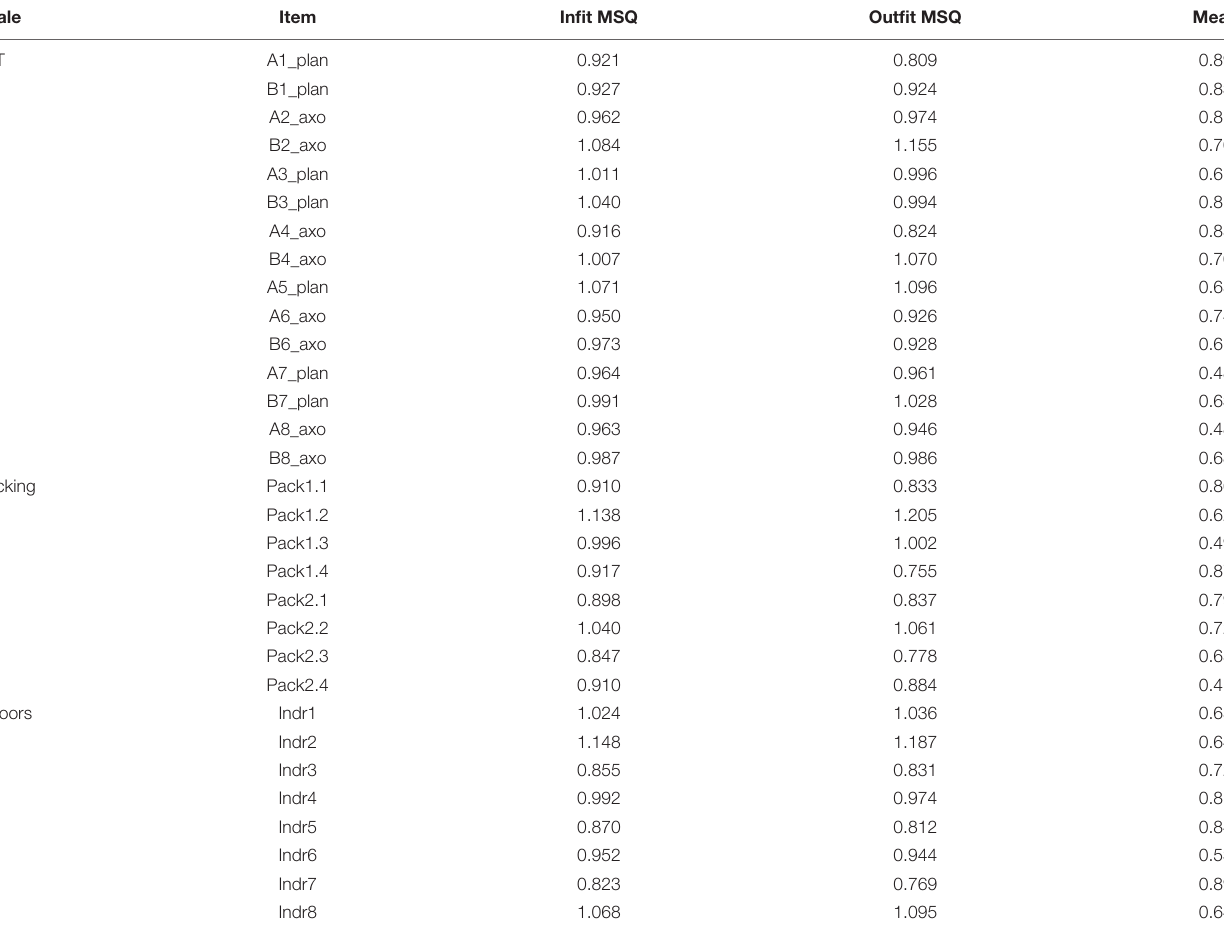
TABLE A1 | Infit and outfit measures per item.